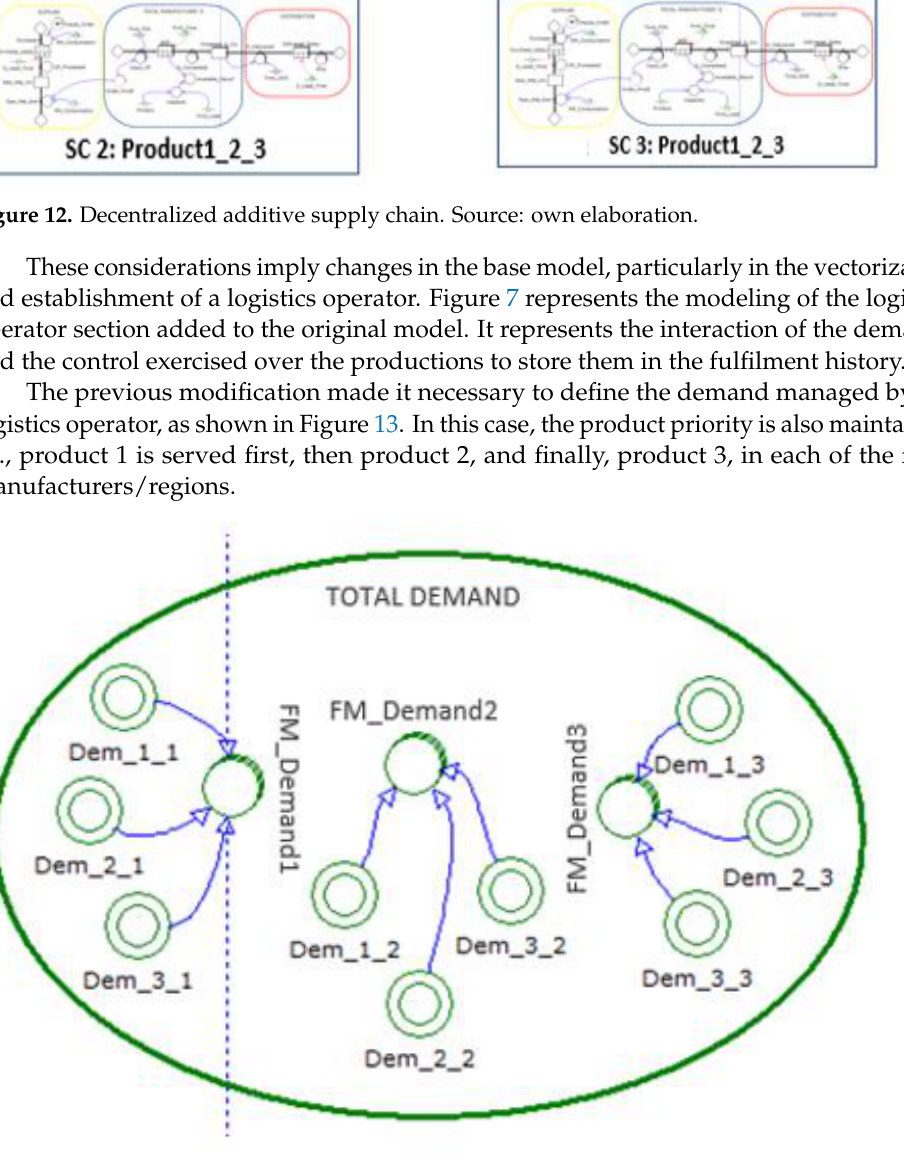
Figure 13. Demand managed by the logistics operator. Source: own elaboration. Evolution Figure 16. Demand managed by the logistics operator. Source: own elaboration. Evolution software. Figure 15. Decentralized additive supply chain. Source: own elaboration.